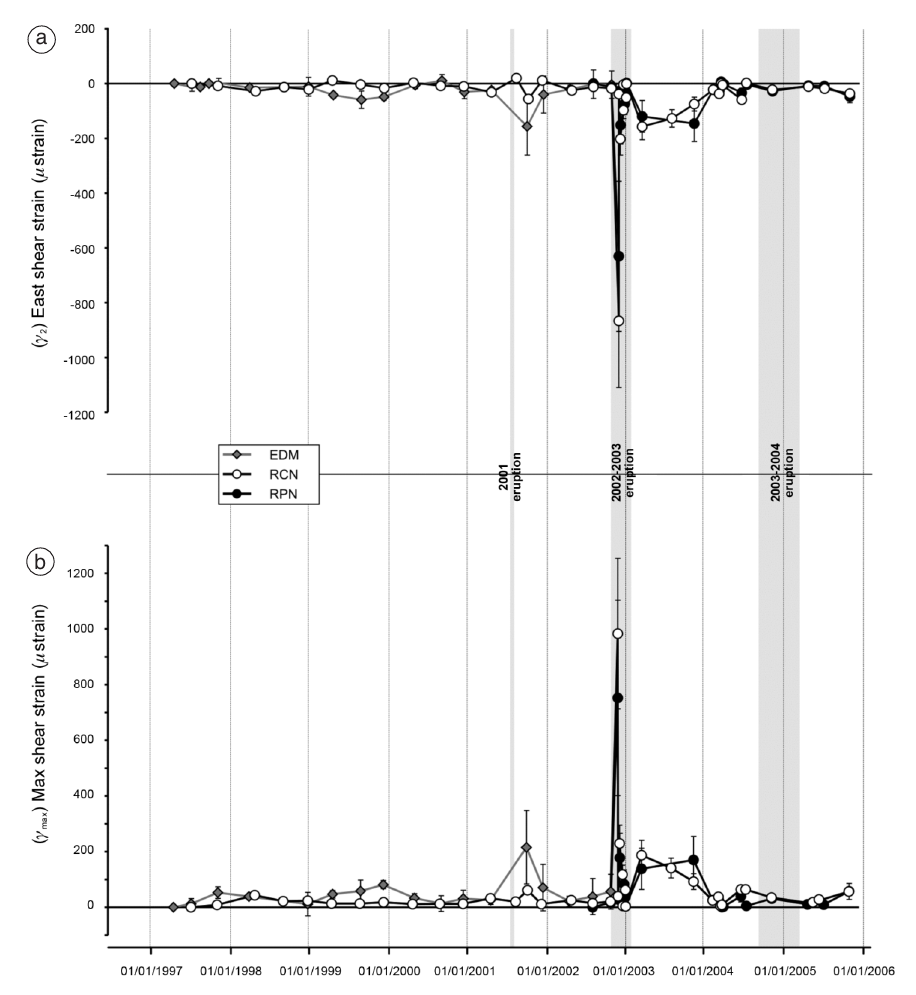
Fig. 7a,b. Time evolution of strain patterns at the geodetic networks: a) east shear strain pattern (strain is as- sumed to be positive for right-lateral shear); b) maximum shear strain